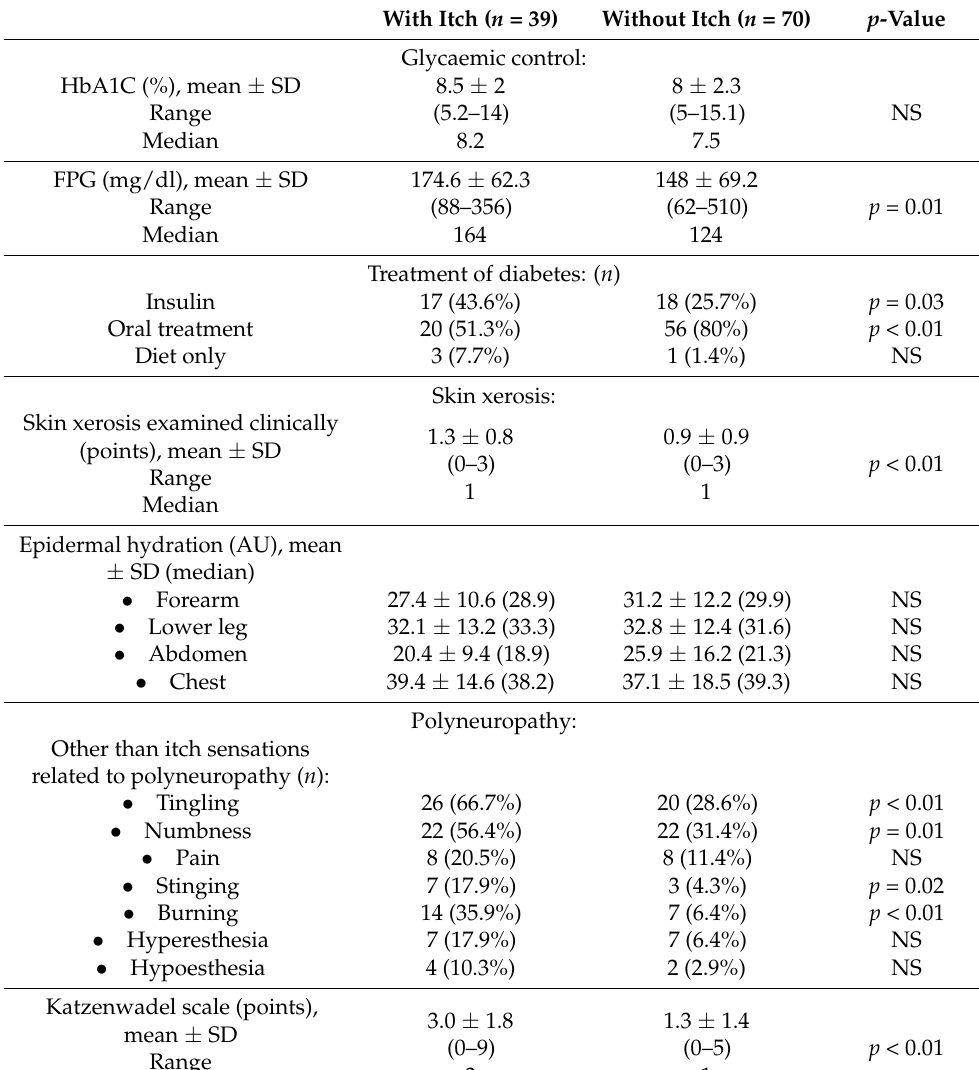
Table 3. Studied etiopathogenetic factors contributing to itch in diabetes mellitus and dependencies on selected clinical